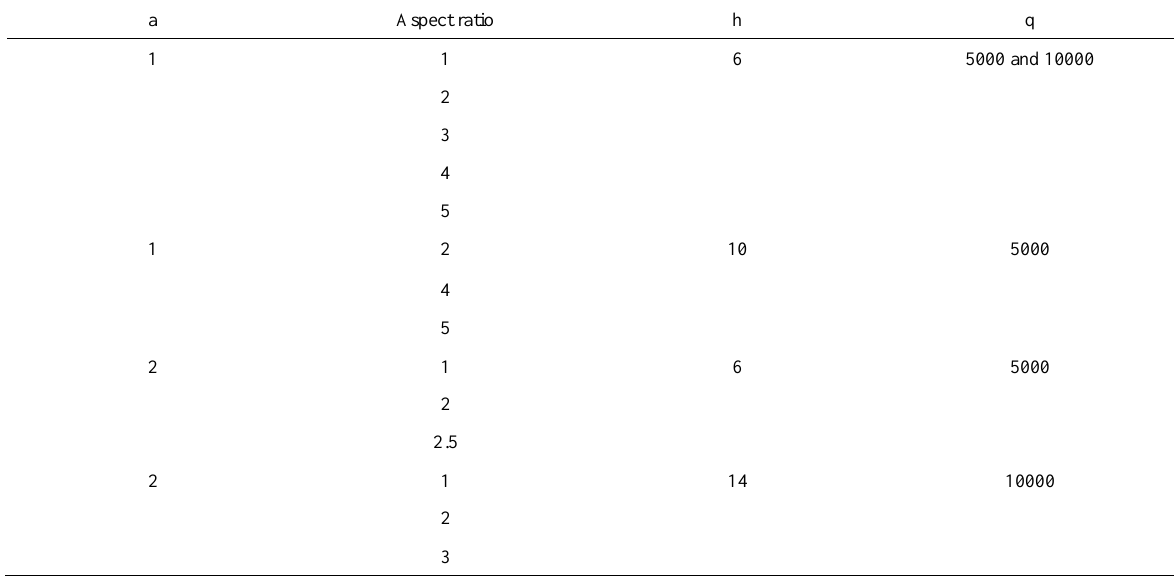
Table 3: Parameters varied for the comparison of the approximated solution of Von Karman equation and the plate deflection calculated by FEA.